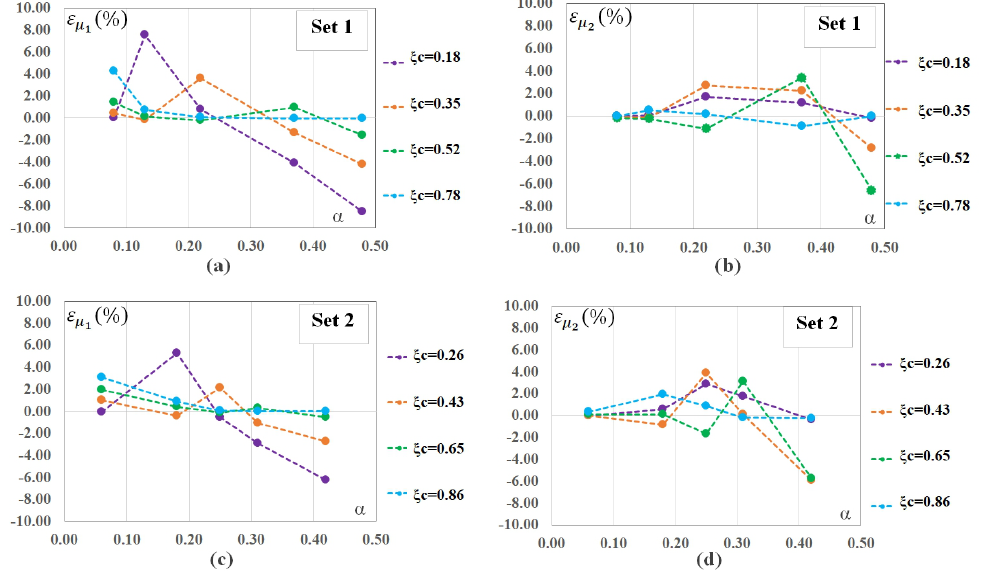
Figure 14. Closed-form solutions application to random data, different from those used to develop them. Percentage errors between real values and estimated ones. ( a ) Set 1. α vs. ε µ ε µ ; ( c ) Set 2. α vs. ε µ ; ( d ) Set 2. α vs. ε µ 2 2 1